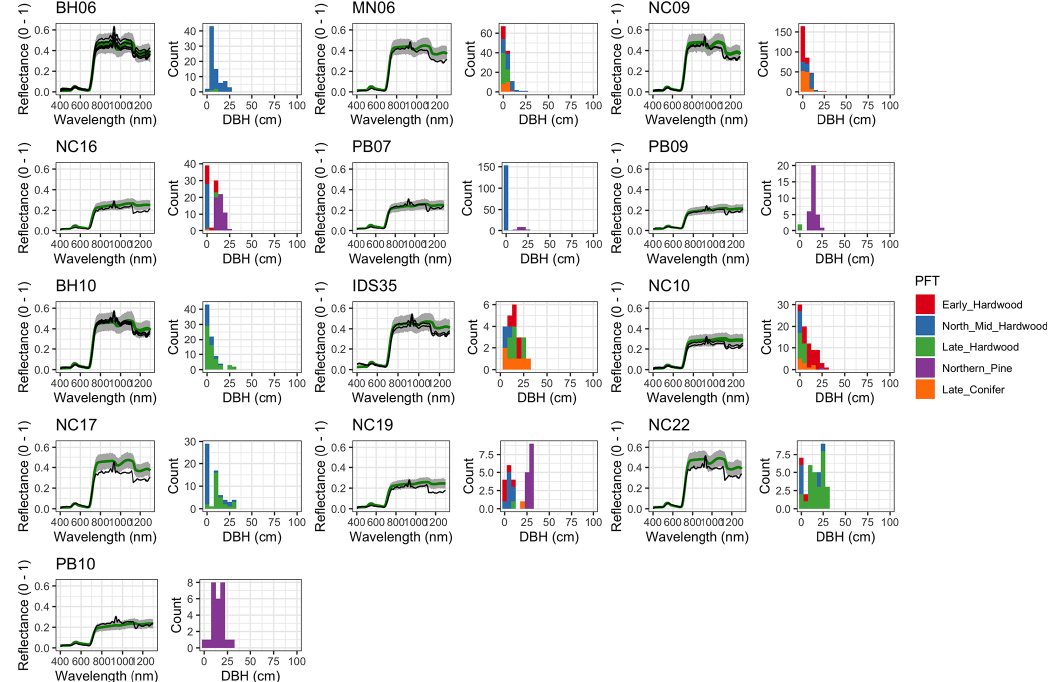
Figure A8. As above but for the second quartile of sites by